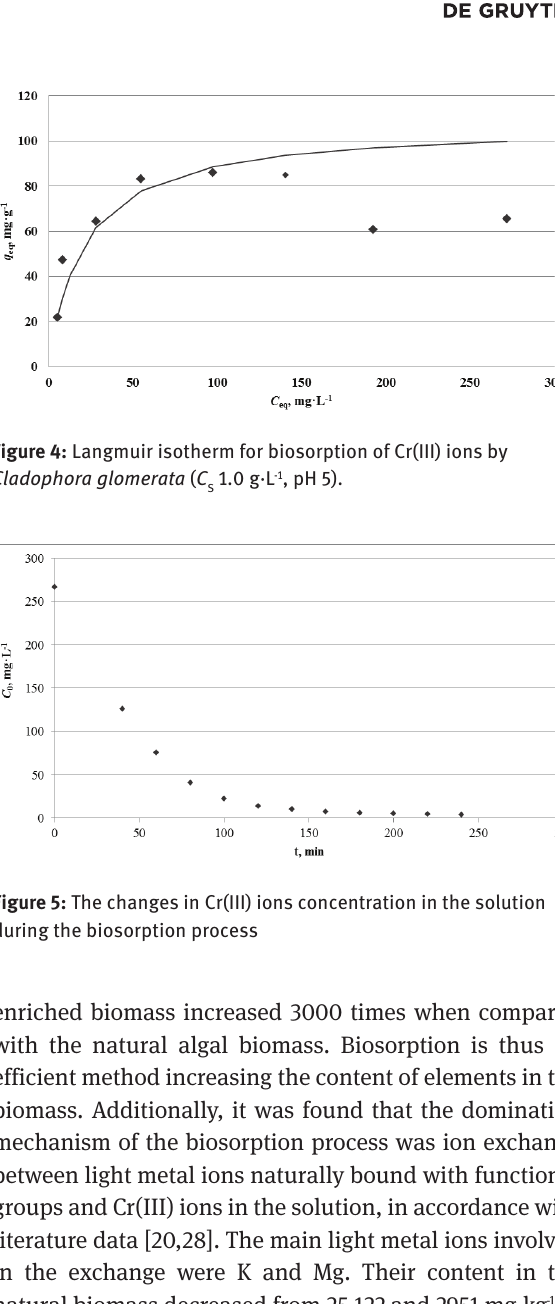
Figure 4. Langmuir isotherm for biosorption of Cr(III) ions by Cladophora glomerata ( C S 1.0 g L -1 , pH 5)